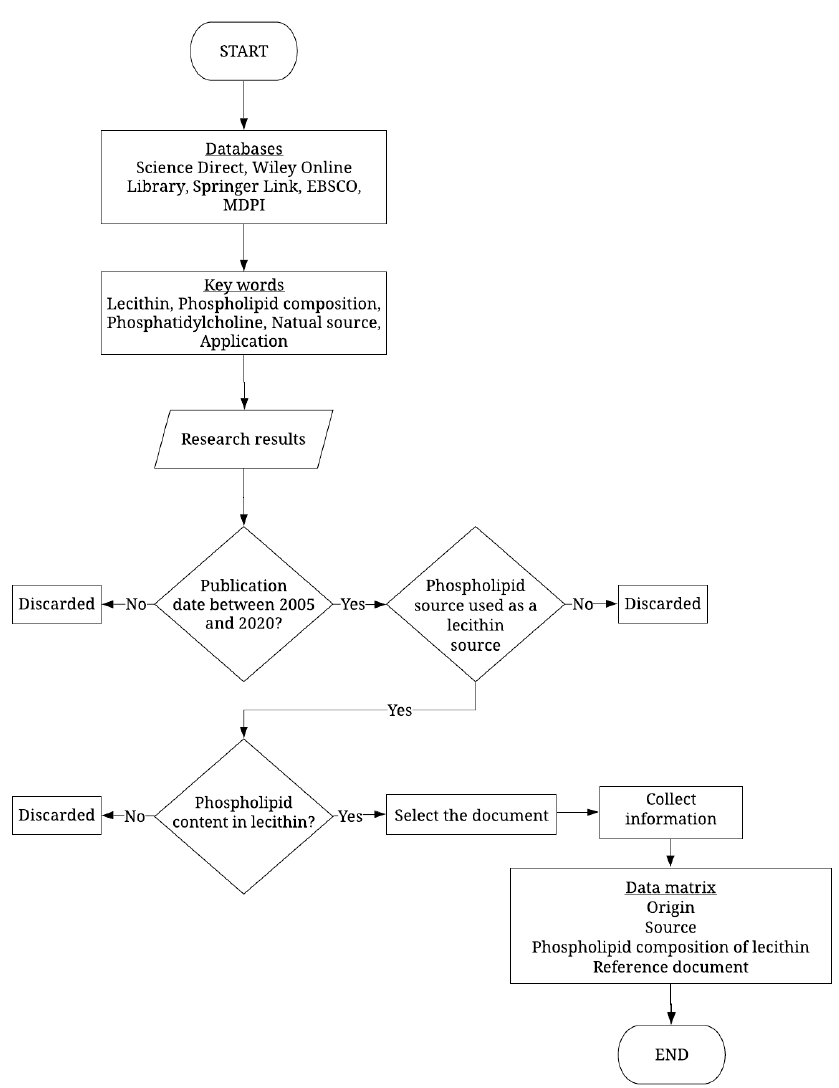
Figure 2. Flowchart showing the information on the search methodology.